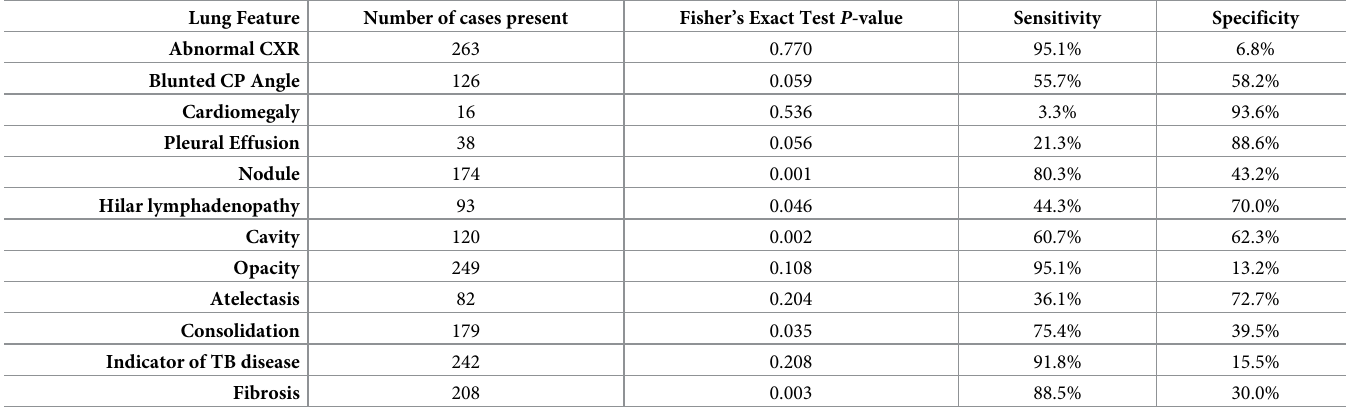
Table 10. 281 Qure.ai classifier binary value predicting TBPP outcome died/failure. Lung